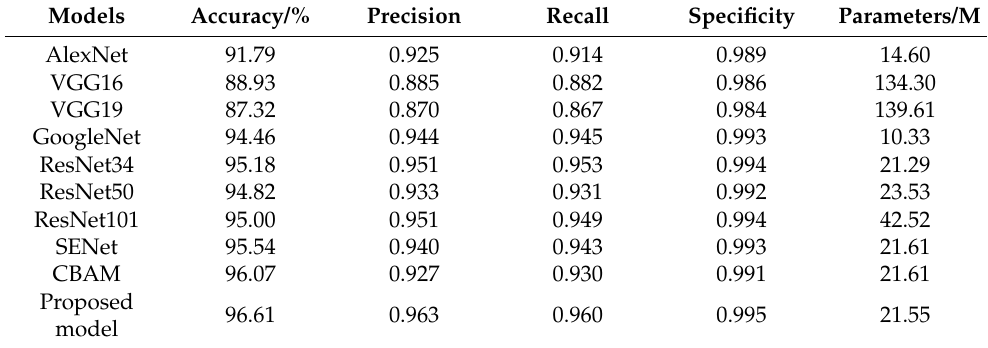
Table 4. Comparison test results between the constructed model and the other nine mainstream models. Models Accuracy/%